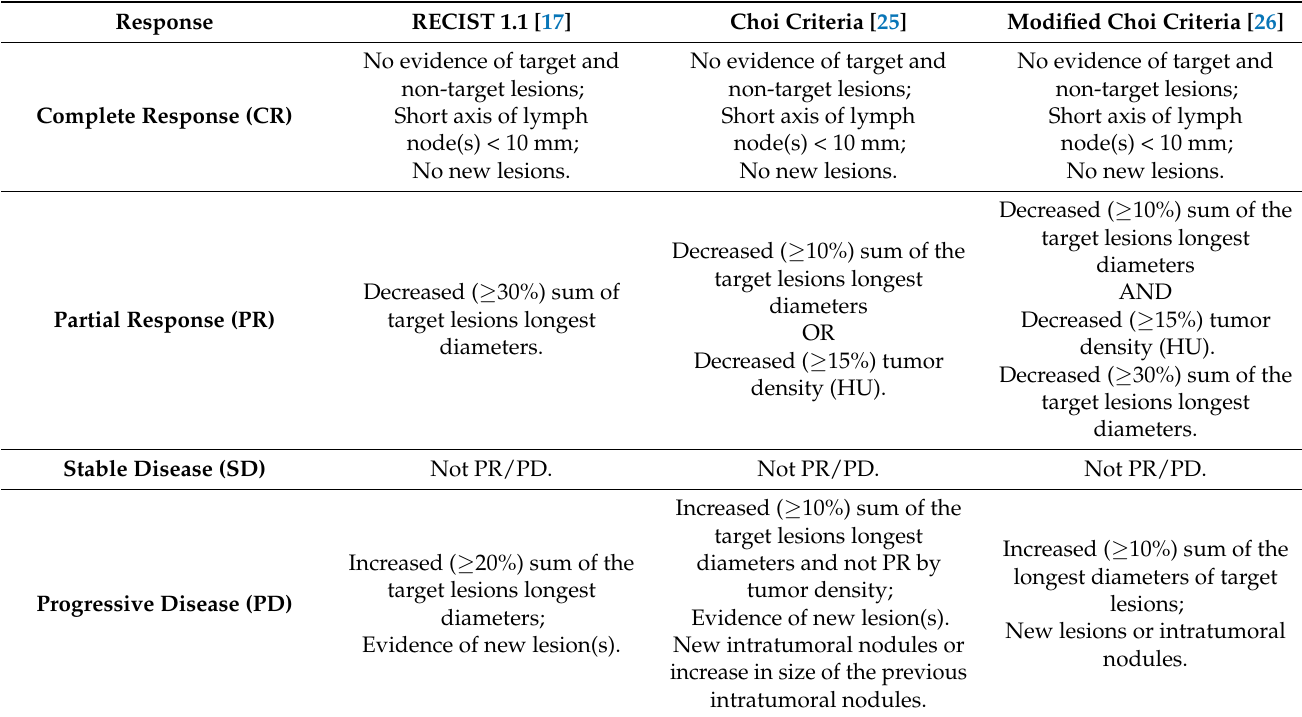
Table 1. Imaging tumor response criteria to antiangiogenic